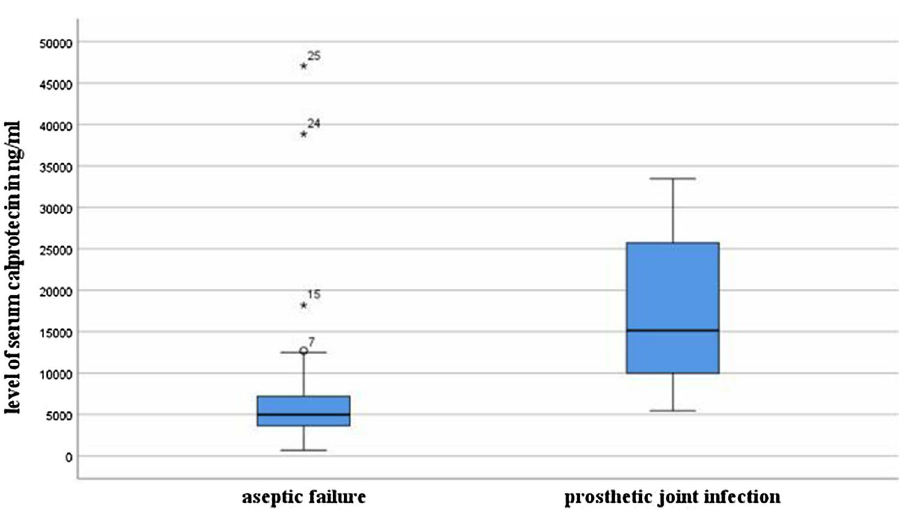
Figure 2. Levels of serum calprotectin in infected and non-infected patients.